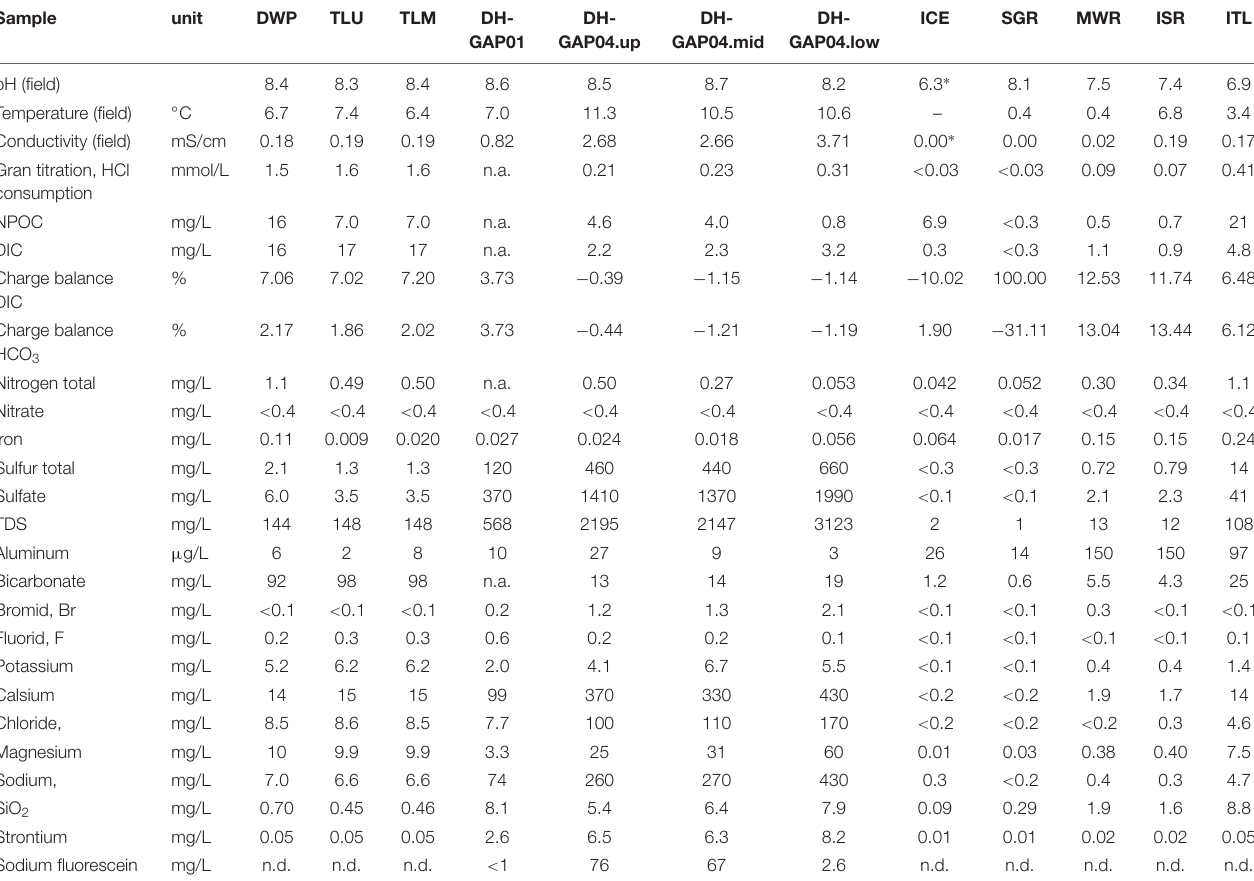
TABLE 2 | The chemical characteristics of the sampled